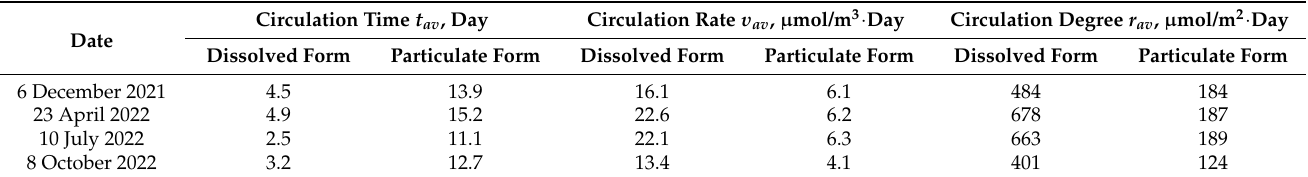
Table 3. Parameters of phosphorus